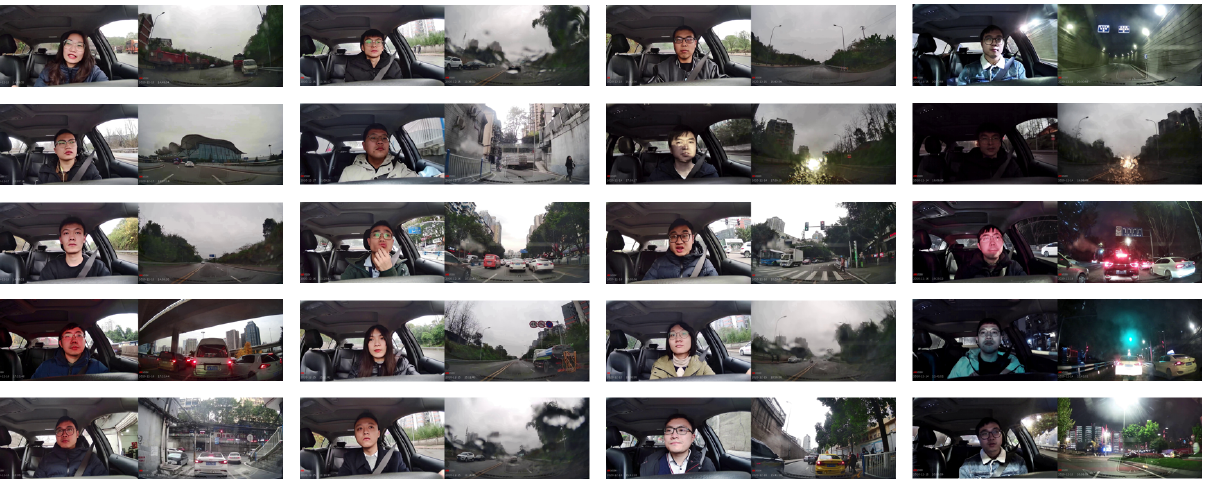
Figure 4. Collected on-road driver facial expression dataset. Each clip contains the driver facial expression and road scenario synchronously; the driver facial expression is induced by various scenarios during day (the first three columns) and night (the fourth